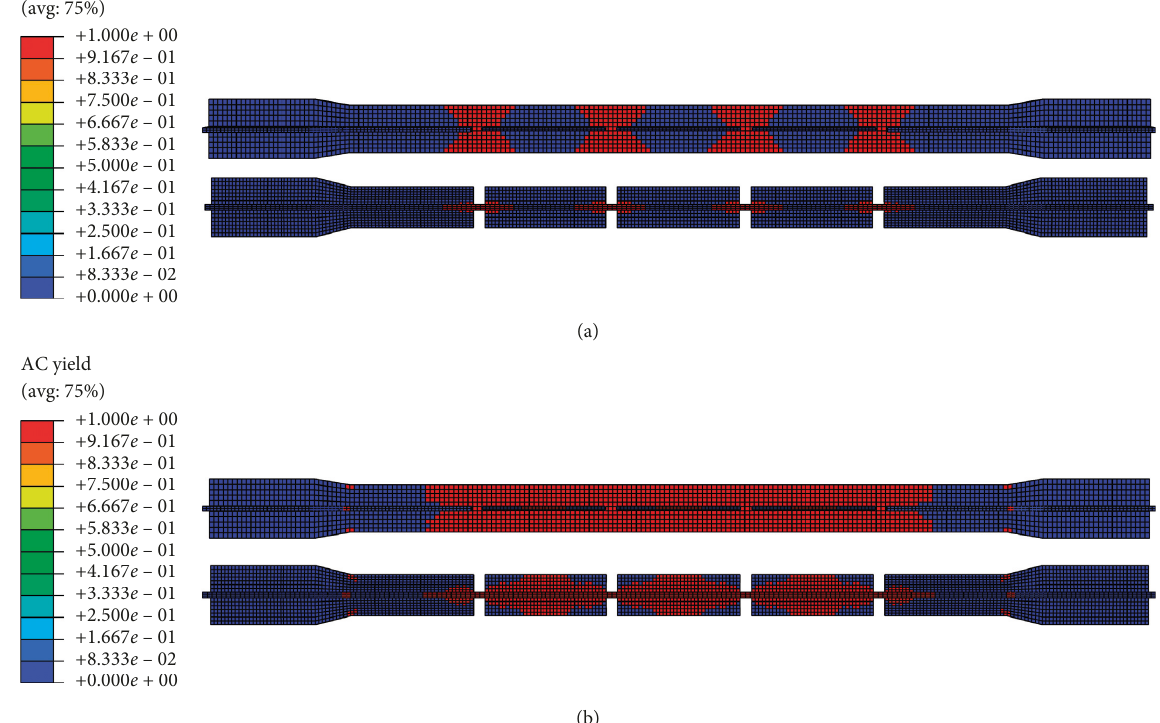
� 1.37 mm and F � 224.2 kN). (b) Stiffened-plate y1 y1